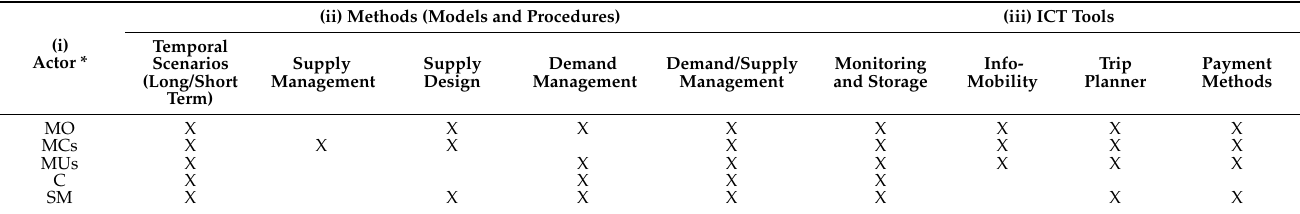
Table 1. Main interaction between actors, evaluation methods and ICT.